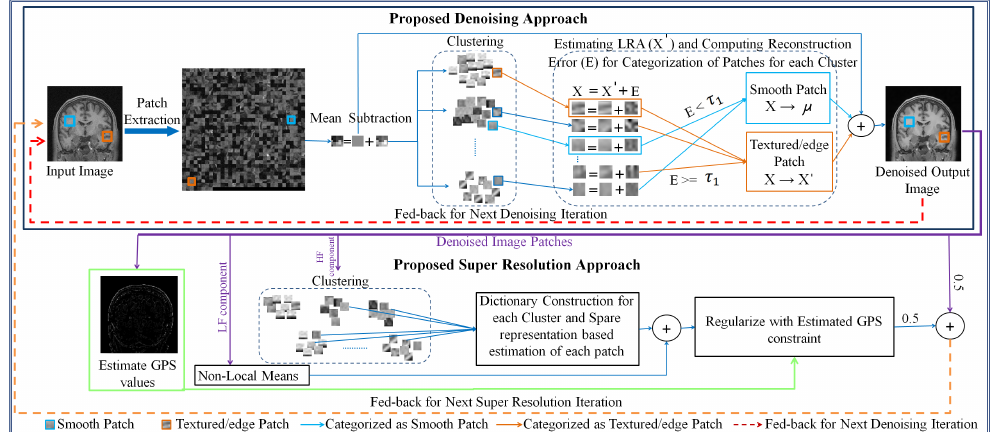
Figure 1. Detailed illustration of the proposed